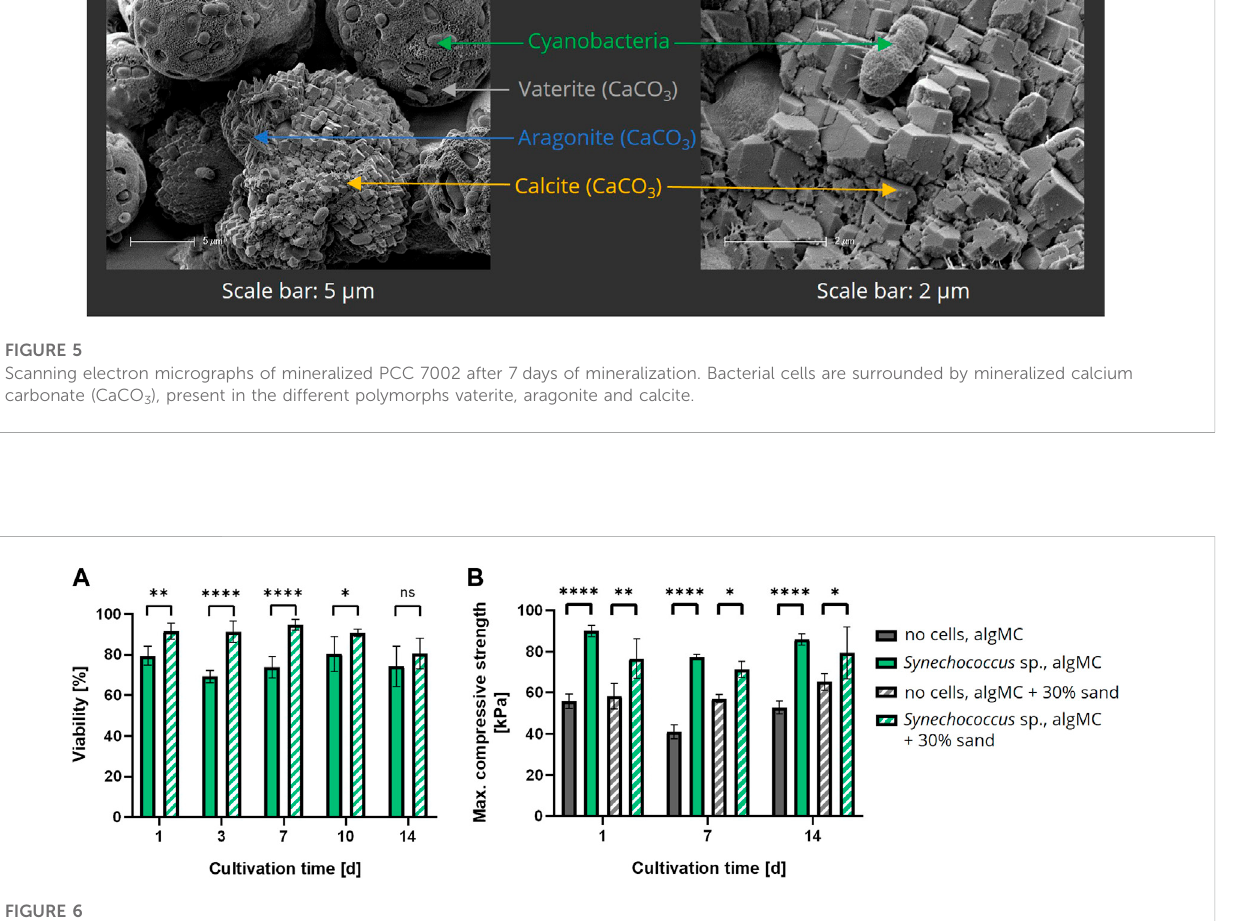
FIGURE 6 (A) Viability of bioprinted PCC 7002 in the algMC bioink without and with 30 wt% of sand over a cultivation period of 14 days (mean ± SD, n = 6, **** p < 0.0001, ** p < 0.01, * p < 0.1). (B) Maximum compressive strength of wet scaffolds without cells (=abiotic control) and with PCC 7002